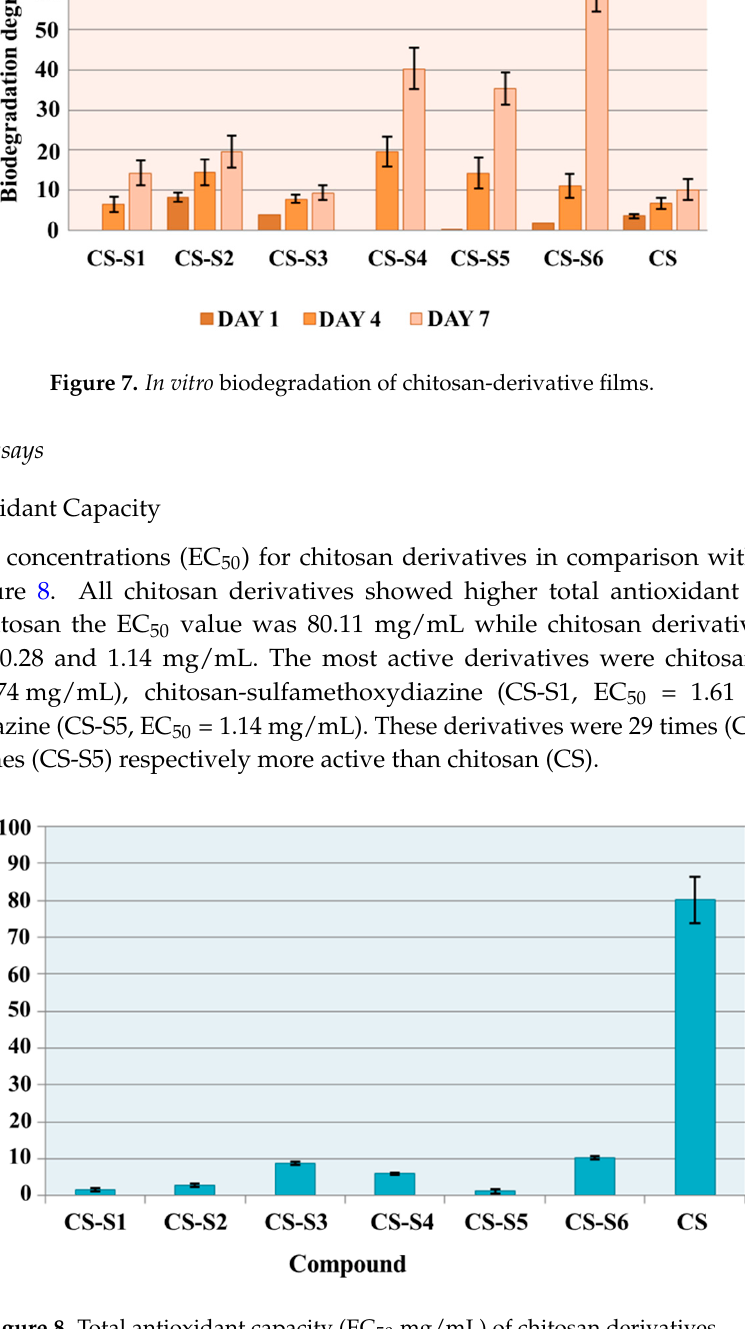
Figure 8. Total antioxidant capacity (EC 50 mg/mL) of chitosan derivatives.